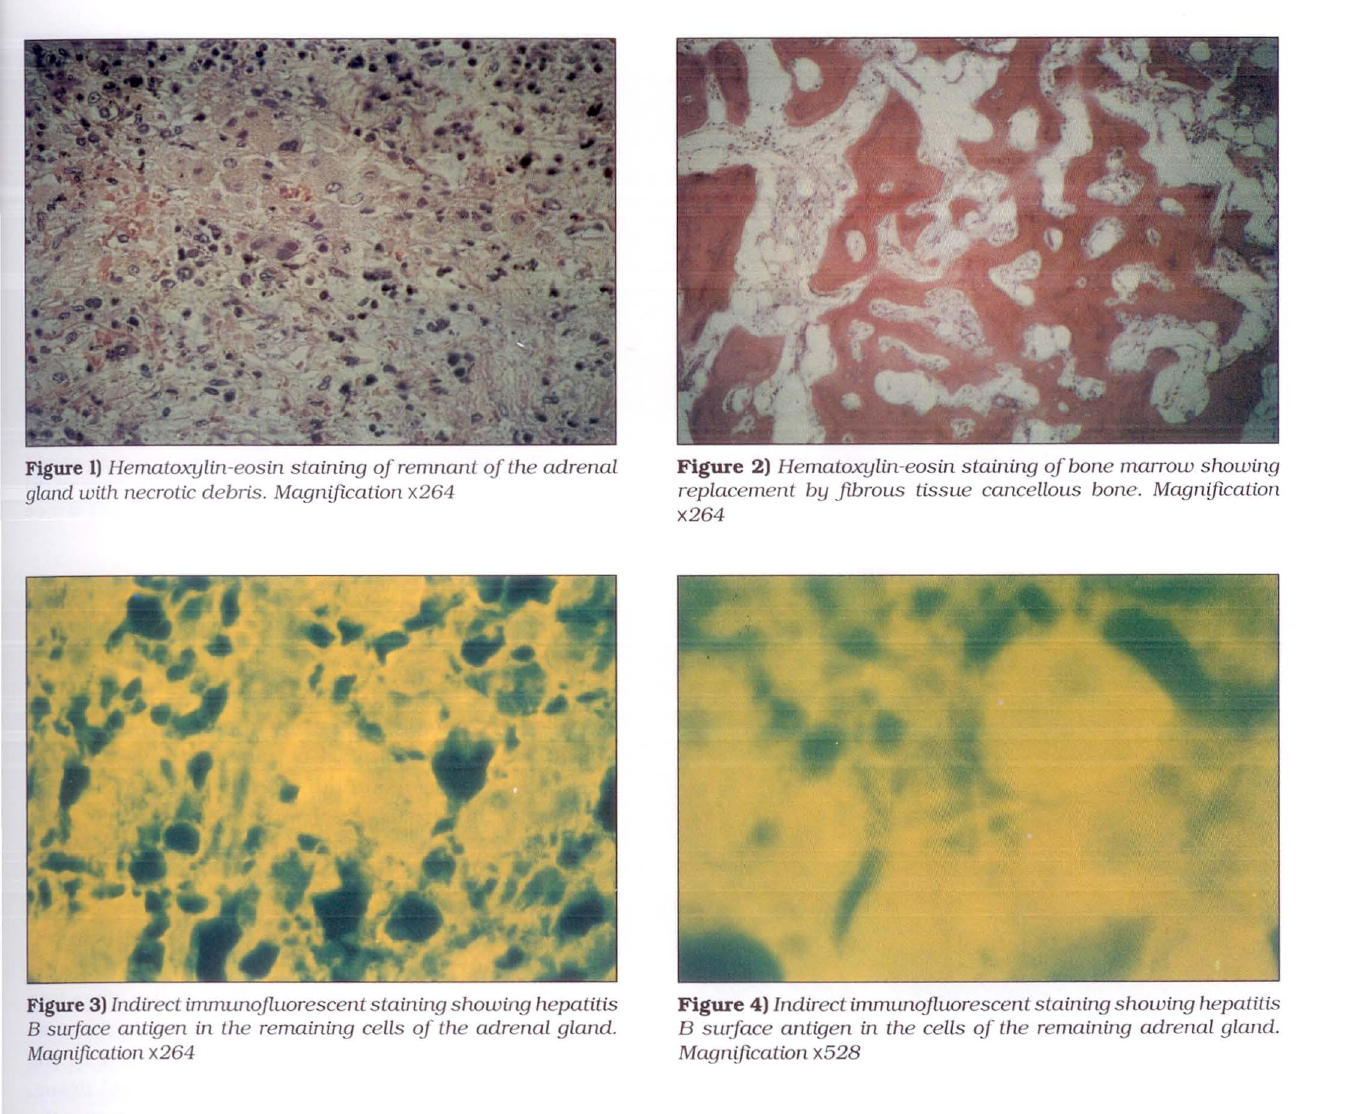
Figure 4) Indirect immunofluorescent staining showing hepatitis B surface antigen in the cells of the remaining adrenal